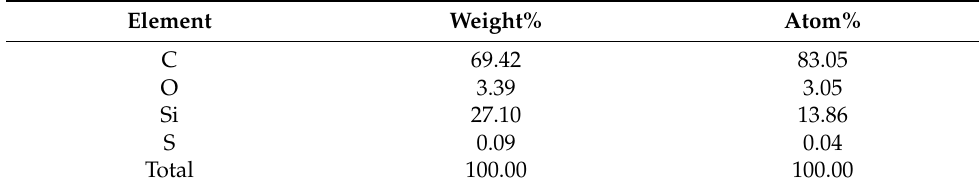
Table 1. Element content of